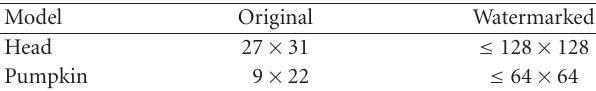
Figure 6: The 2D virtual images of Head ( x , y , and z images in order). Table 2: Numbers of control